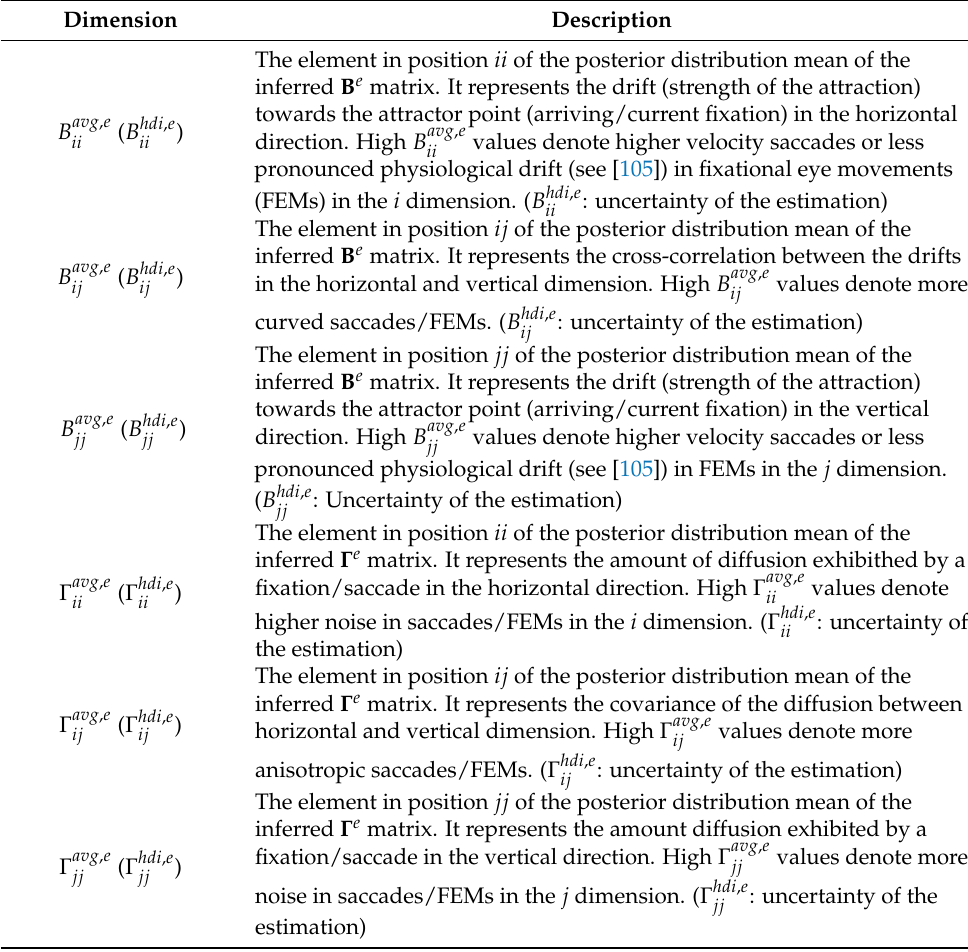
Table 2. Summary of the proposed features and related physical